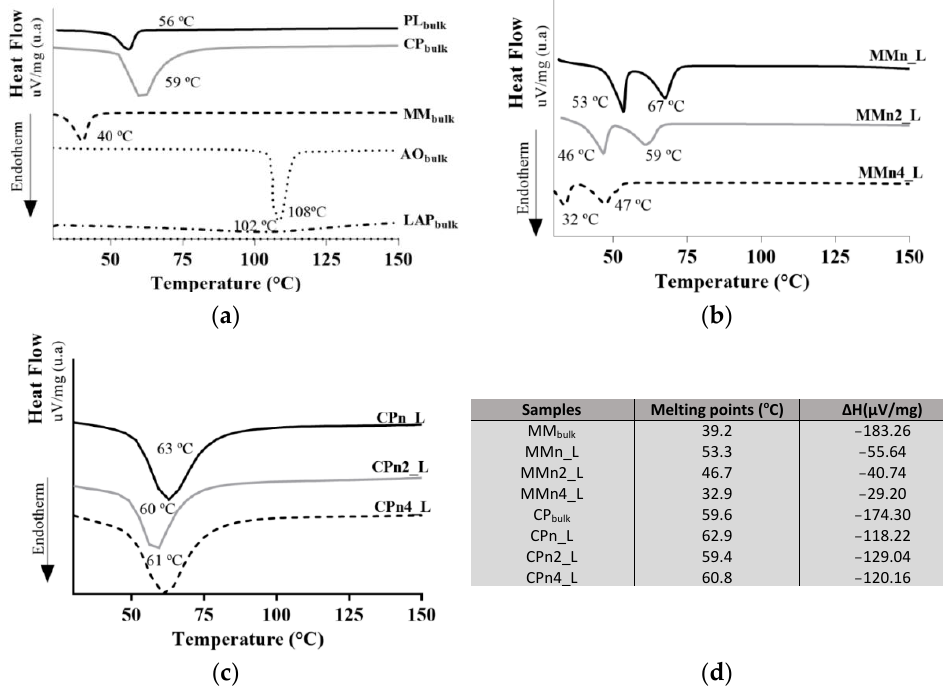
Figure 3. DSC curves of compounds of formulations ( a ), hybrid systems in the presence of AO at 2 and 4% ( w/w ) prepared with MM ( b ) and CP ( c ). Table ( d ) shows the melting enthalpies of the lipids and the hybrids .